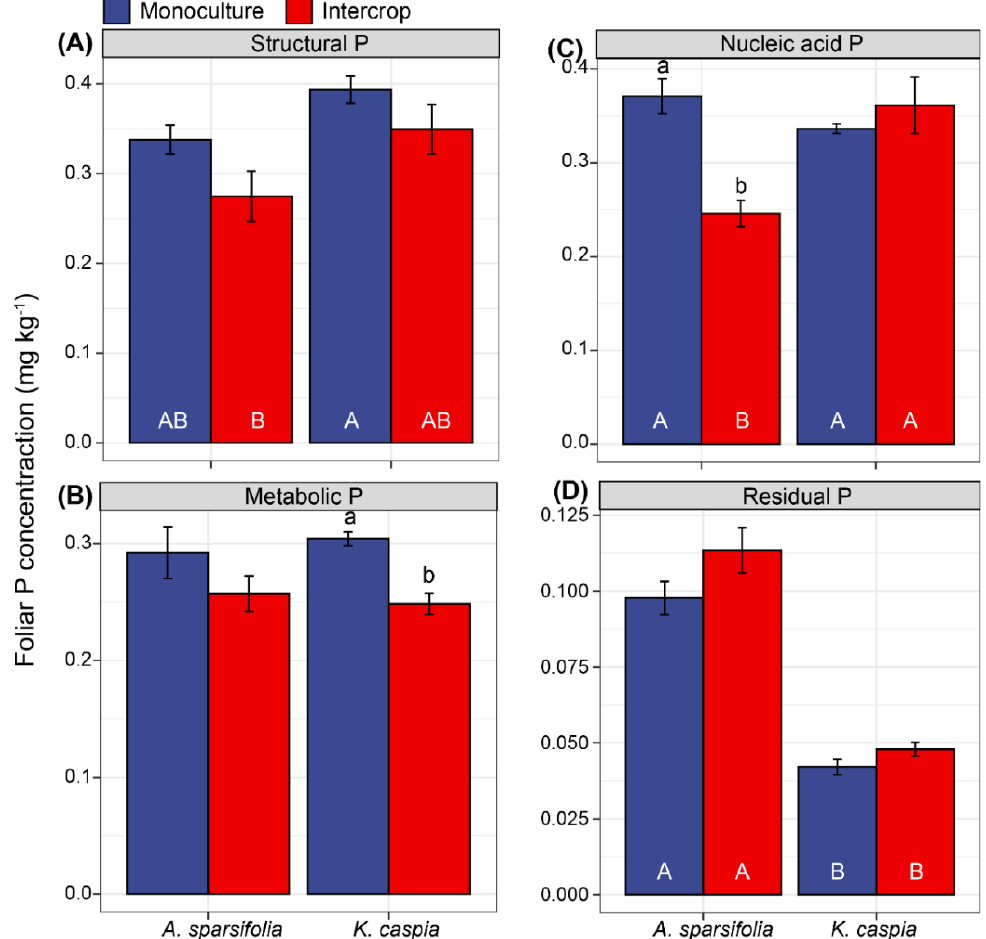
Figure 6. The concentrations of foliar ( A ) structural P, ( B ) metabolic P, ( C ) nucleic acid P, and ( D ) residual P in plants of A. sparsifolia and K. caspia monocultures and their intercrop(four groups). Values are means ± SE (n = 5). Different capital letters below the bars indicate significant differences at p < 0.05 among four treatments, and lowercase letters above error bars indicate significant differences at p < 0.05 among different plant communities ( Alhagi sparsifolia (legume) monoculture, Karelinia caspia (non-legume) monoculture, and both species intercropped).